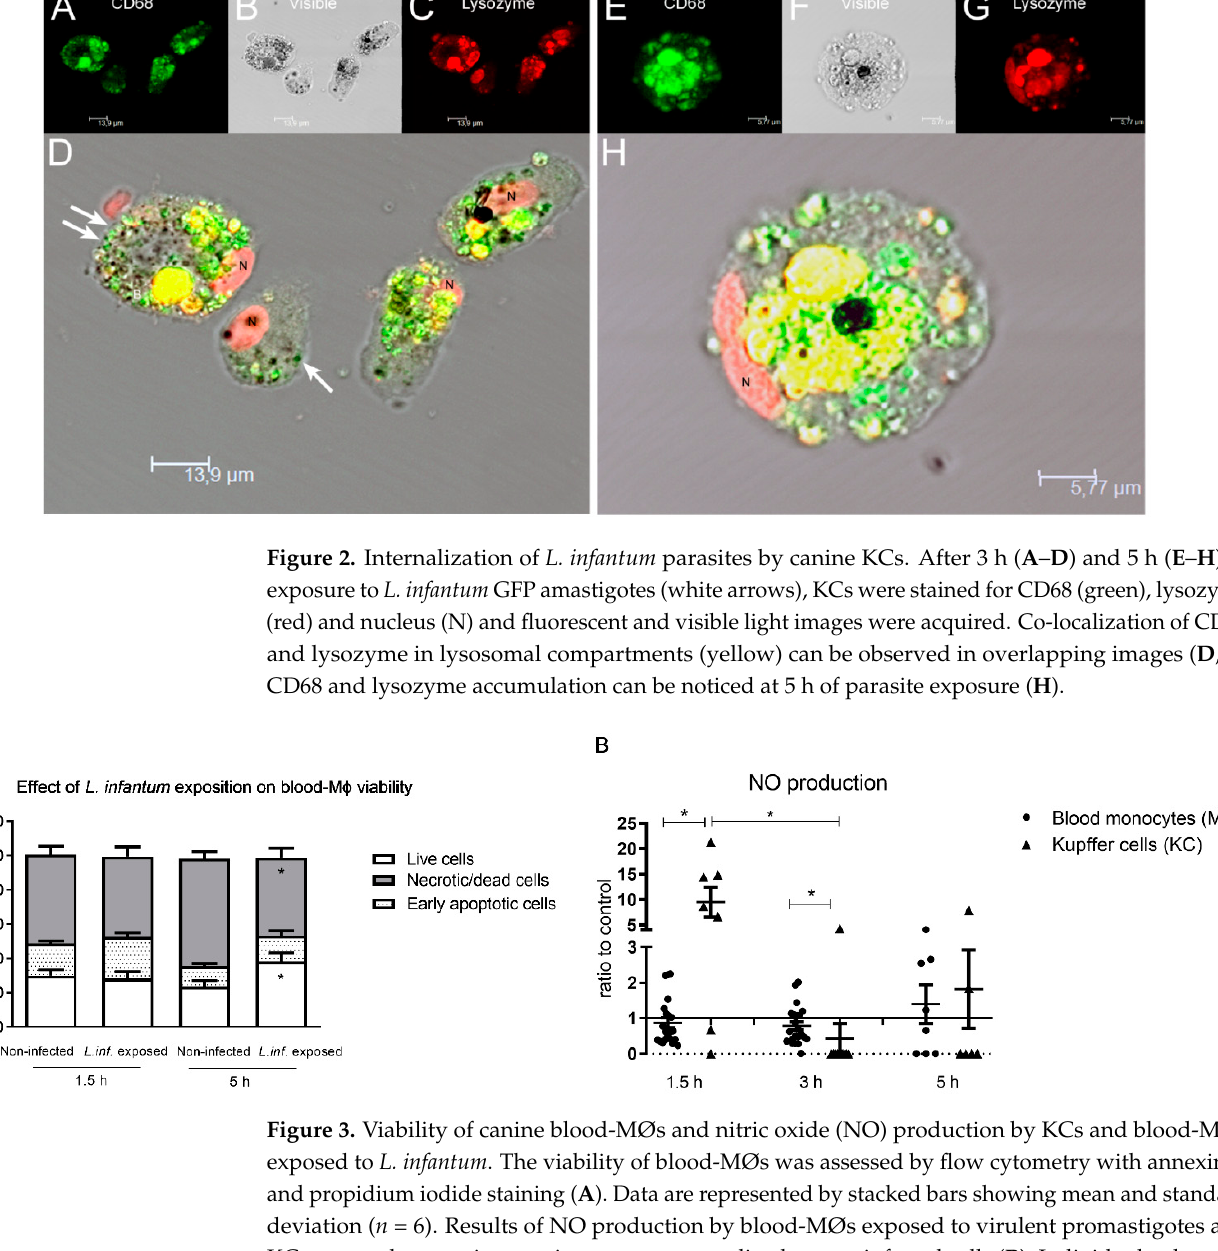
Figure 3. Viability of canine blood-MØs and nitric oxide (NO) production by KCs and blood-MØs exposed to L. infantum . The viability of blood-MØs was assessed by flow cytometry with annexin-V and propidium iodide staining ( A ). Data are represented by stacked bars showing mean and standard deviation ( n = 6). Results of NO production by blood-MØs exposed to virulent promastigotes and KCs exposed to axenic amastigotes were normalized to non-infected cells ( B) . Individual values are indicated as black dots (blood-MØs) and black triangles (KCs) with mean and standard deviation ( n = 10). Non-parametric Wilcoxon test was used for statistical comparisons. * ( p < 0.05) indicate significant differences.